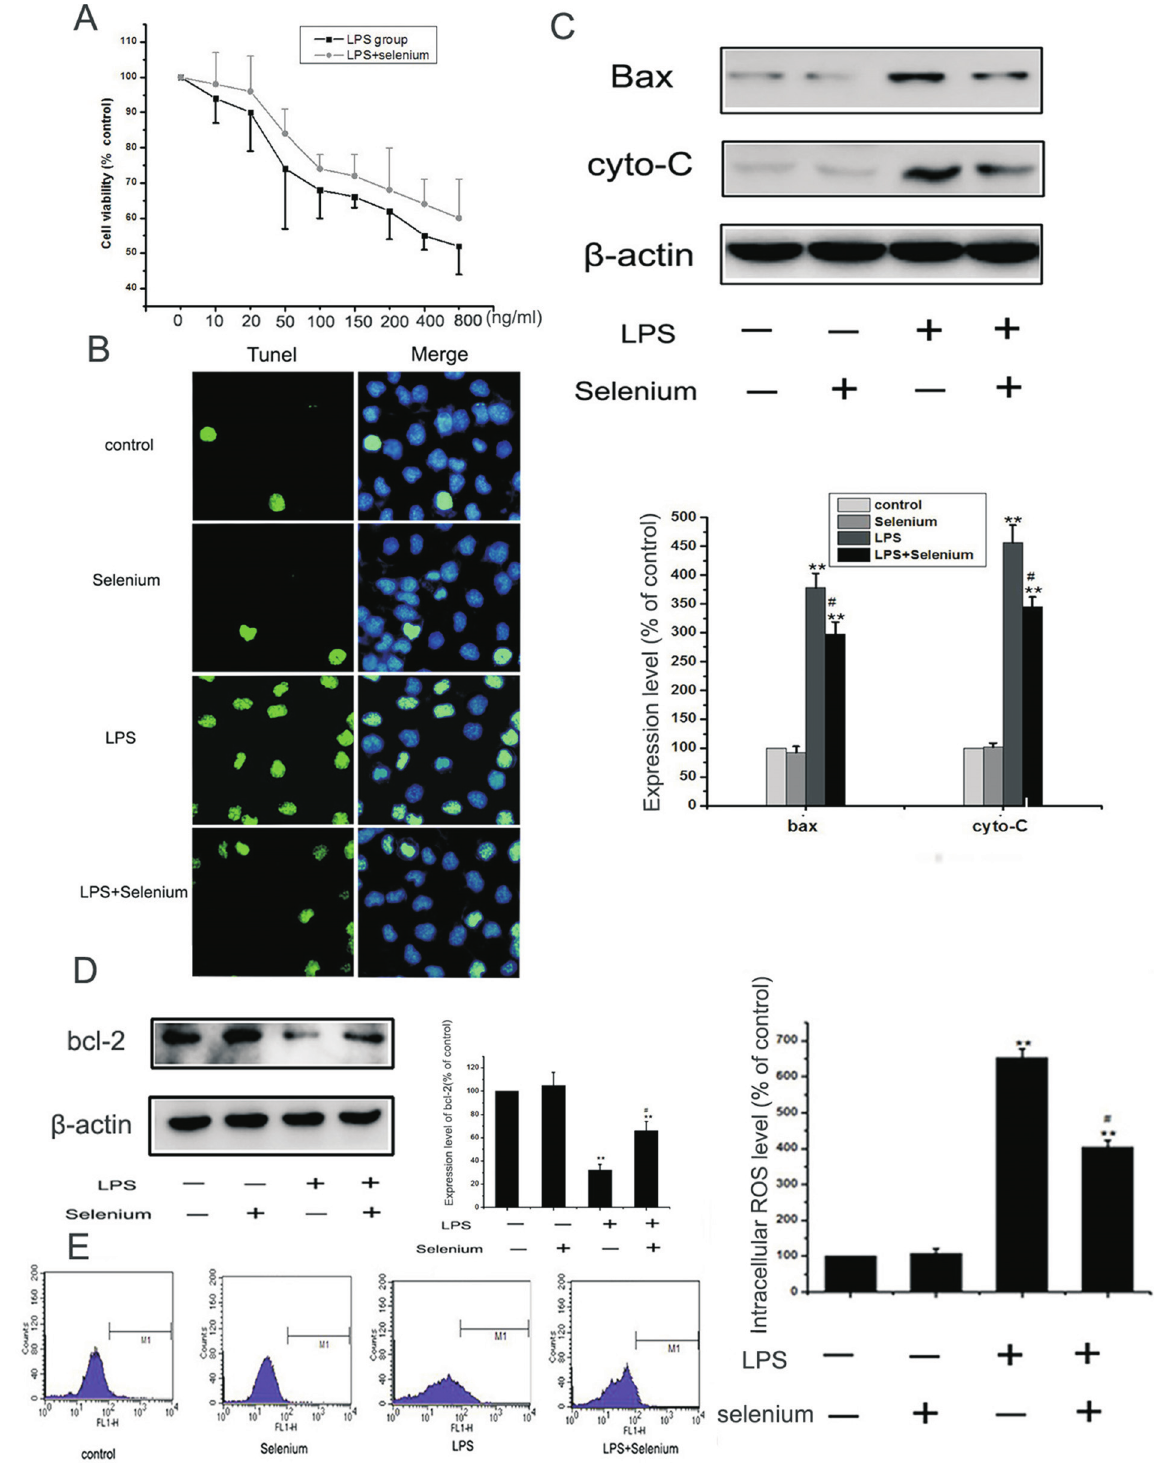
Figure 2 - Selenium inhibited LPS-induced apoptosis and oxidative stress in MC3T3-E1 cells. (A) We incubated MC3T3-E1 cells with 0-800 ng/ml of LPS with or without 4 ng/ml sodium selenite for 48 h, and cell viability was detected by MTT. The data were mean (cid:6) SEM (n=5). (B) MC3T3-E1 cells were incubated in 200 ng/ml LPS in the presence or absence of 4 ng/ml sodium selenite for 24 h, and the apoptosis was assessed by using TUNEL analy- sis. (C,D) Cells were treated as above, western blots were performed with the antibodies indicated. Relative expression of Bax, cytochrome c and bcl-2 were calculated and normalized to the loading control (cid:2) -actin. The data were mean (cid:6) SEM (n = 6). (** P < 0.01, vs. control, # P < 0.05, LPS vs. LPS+sele- nium group) . (E): Cells were treated as aboved, and the level of intracellular ROS production were detected by FACS analysis. The data were mean (cid:6) SEM (n = 3). (** P < 0.01, vs. control, # P < 0.05, LPS vs. LPS+selenium